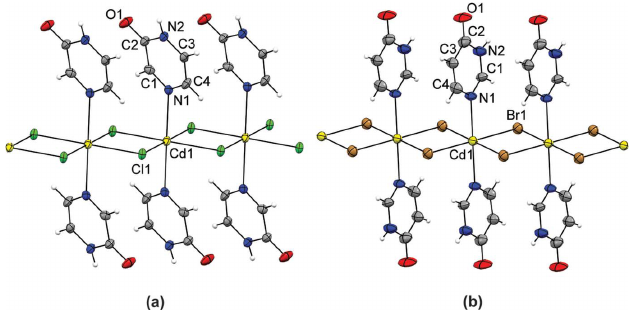
Figure 6 Metal-containing building units ( ORTEP -style plots obtained using Mercury 3.3 ) equipped with pyrazinone (pyz) and pyrimidinone (pym) ligands, ( a ) [CdCl 2 (2-pyz) 2 ] n ( 1 ) and ( b ) [CdBr 2 (4-pym) 2 ] n ( 5 ), respec- tively. The crystal structures of [CdBr 2 (2-pyz) 2 ] n ( 2 ) and [CdI 2 (2-pyz) 2 ] n ( 3 ) are isostructural with each other and with 1 , and the structure of [CdI 2 (4-pym) 2 ] n ( 6 ) is near-identical to that of 5 .